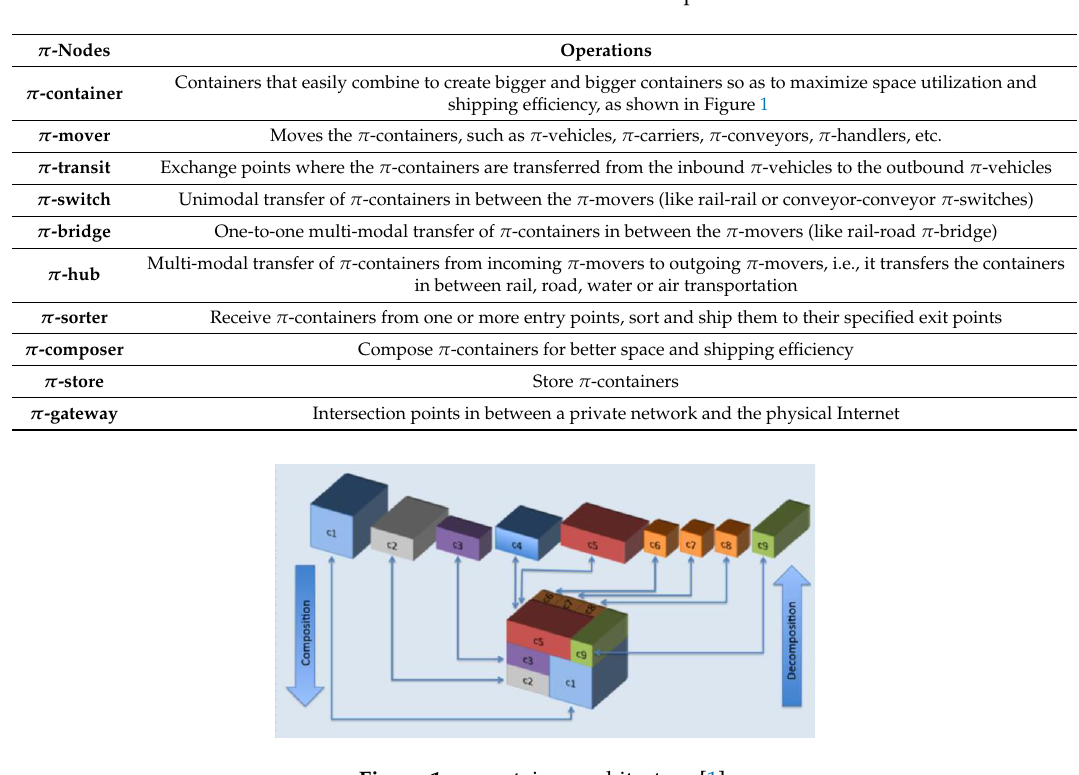
Figure 1. π -container architecture